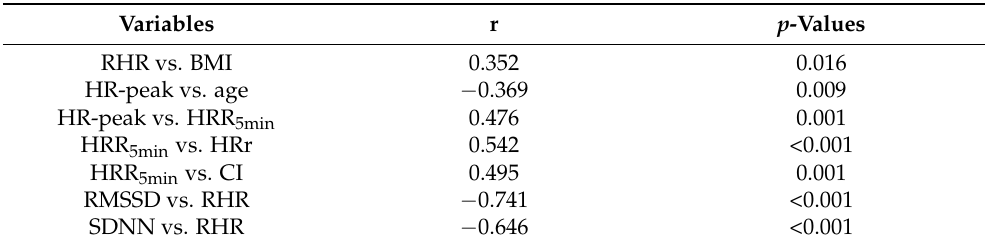
Table 3. Partial correlations of heart rate parameters with cardiorespiratory fitness and anthropomet- ric variables controlled by age and